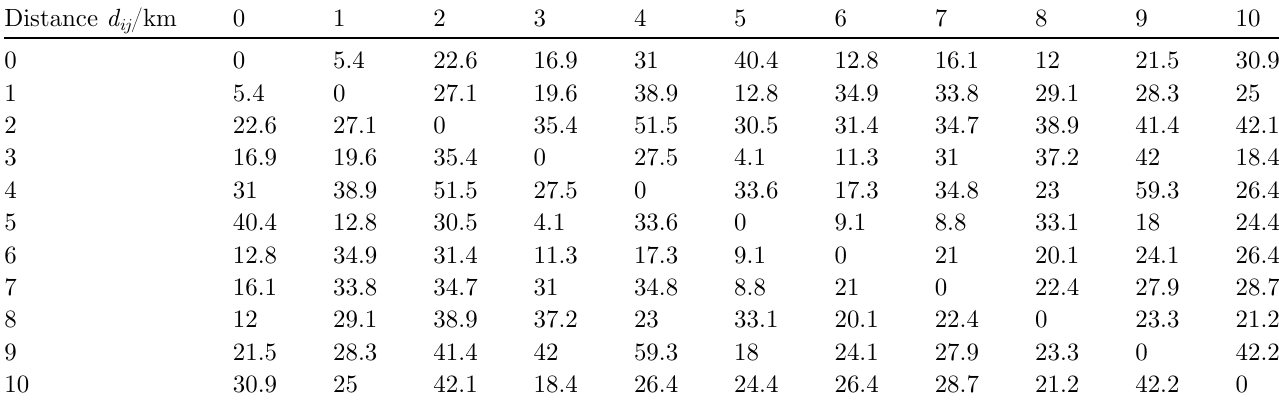
Table 2. Distance between distribution points. Distance d ij /km